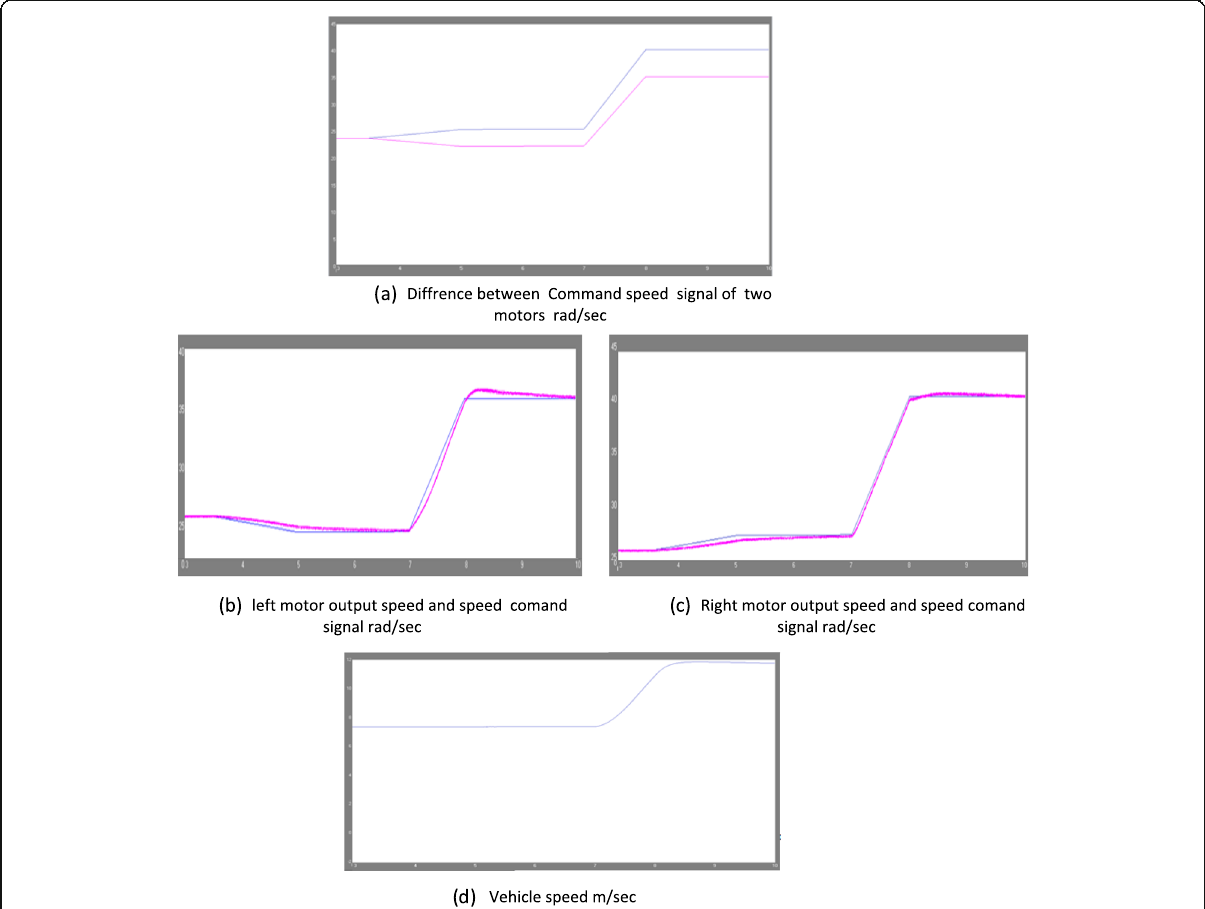
Fig. 10 a Difference between command speed signal of two motors (rad/s). b Left motor output speed and speed command signal (rad/s). c Right motor output speed and speed command signal (rad/s). d Vehicle speed